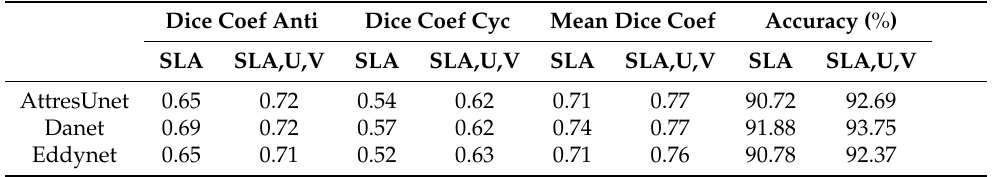
Table 1. Metrics derived from the models trained on two